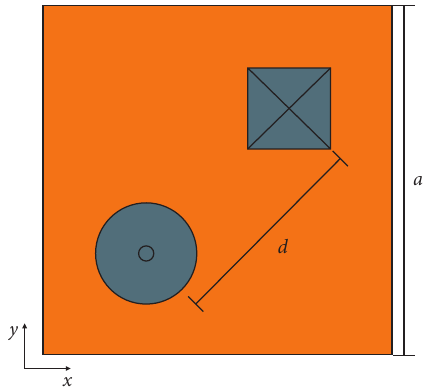
Figure 12: Positioning of the nanoantenna arrangement in the OSC (top view).